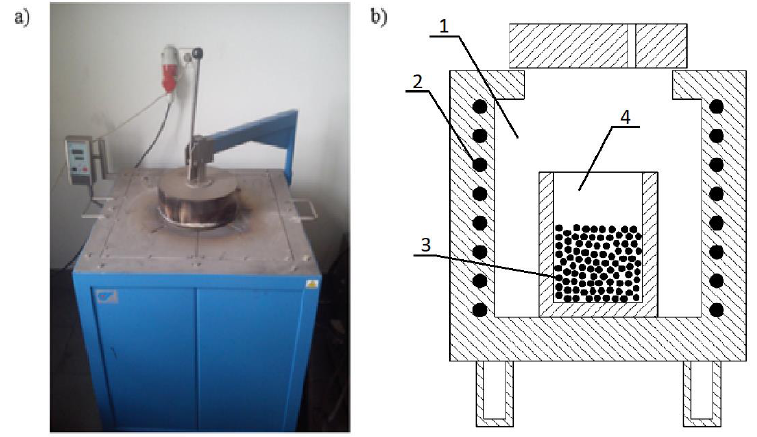
Figure 3. Resistance pit furnace: ( a ) general view, ( b ) diagram of the working chamber: 1 — working chamber, 2 — heating elements, 3 — charge, 4 — ceramic crucible.